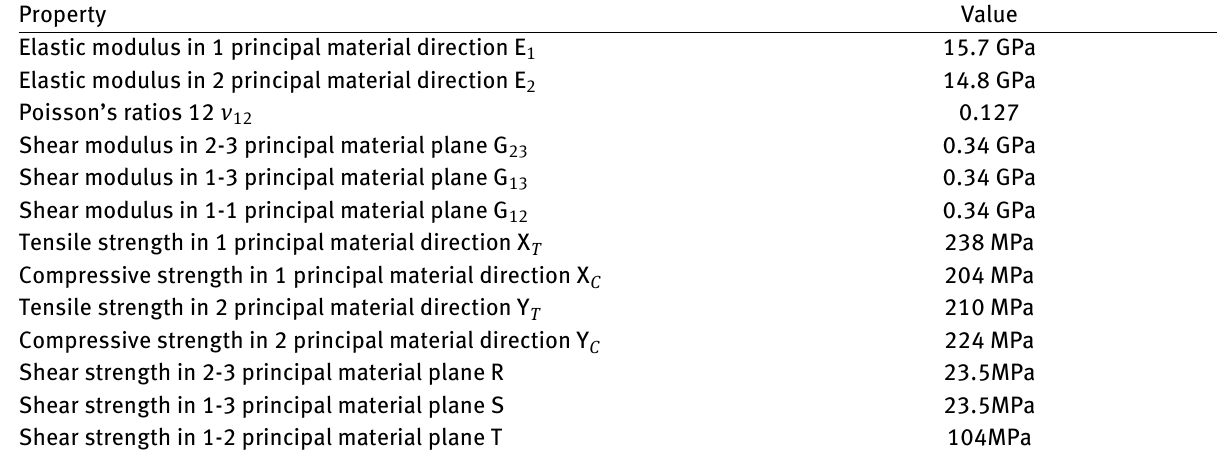
Table 3: Material properties of composite material Property